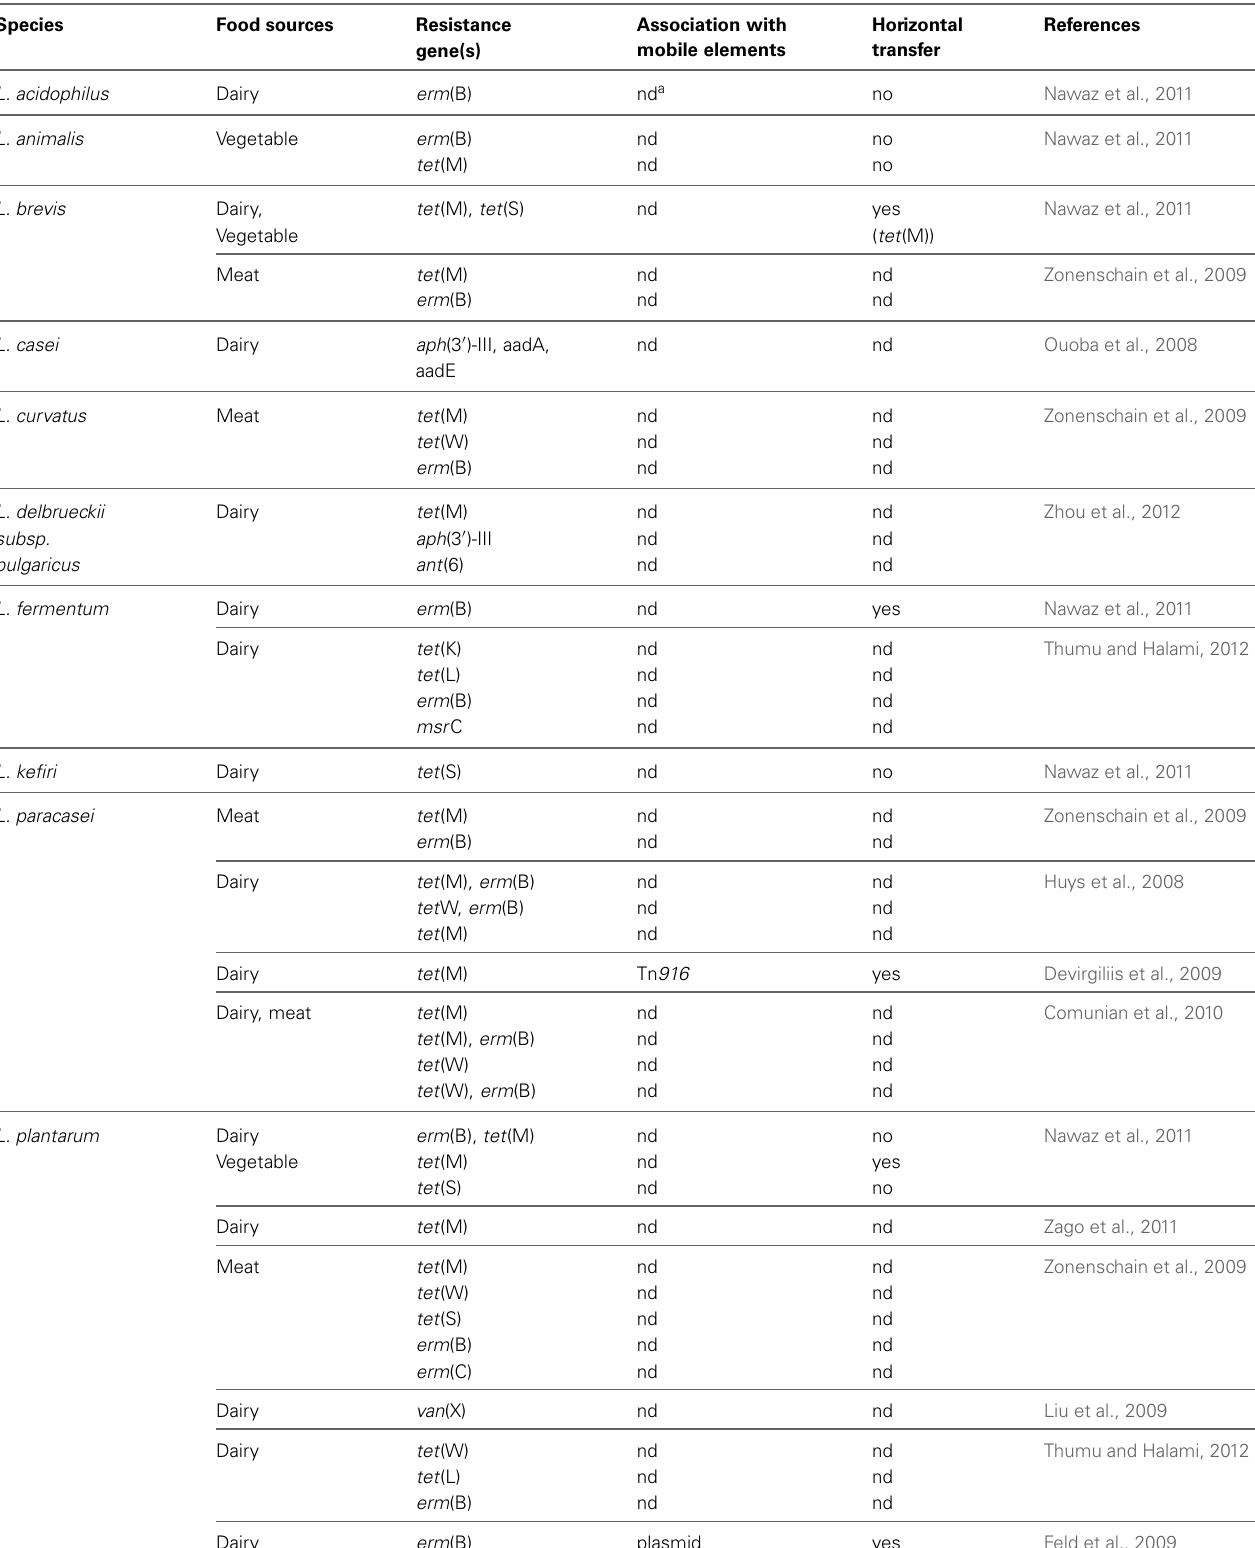
Table 2 | Foodborne Lactobacillus species reported to carry AR genes and sources of